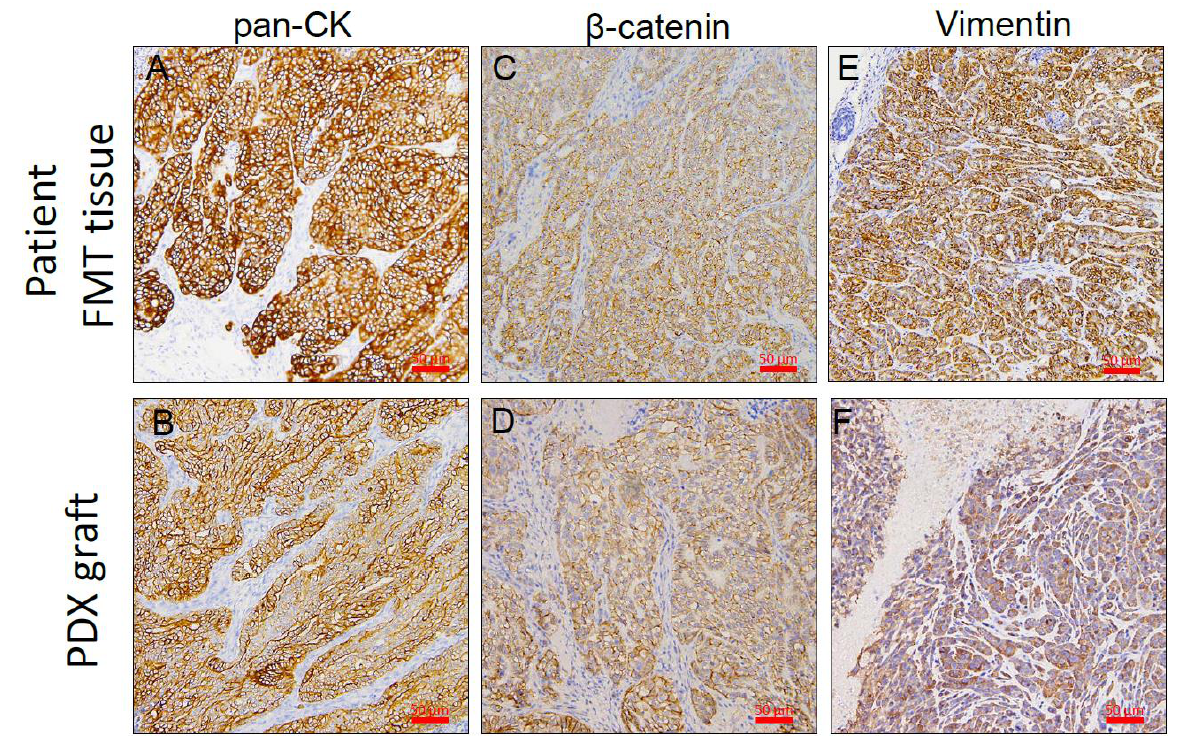
Figure 6. A representative PDX graft (FMT1807) is shown in comparison to the original sample. Sections from the primary FMT of patient cat and from representative PDX grafts from the same individual are shown. Shown are antibody stains for pan-cytokeratin (pan-CK; A , B ), β -catenin ( C , D ) and vimentin ( E , F ). Positive antibody signals are shown in brown, and the hematoxylin counterstain is shown in blue. Bar = 50 μm.